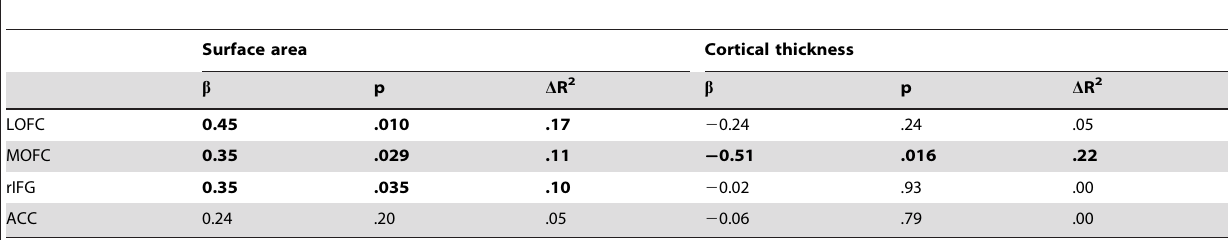
Table 2. Associations of birth weight with bilateral structural measures of cortical regions of interest.